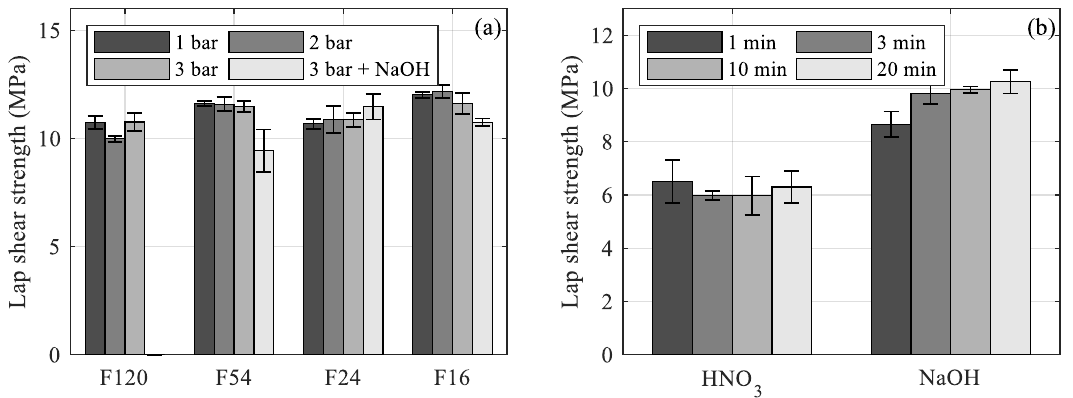
Figure 7. Lap shear test results for ( a ) blasting and combined treatment and ( b ) etching treatment. Table 6. Highest test results and roughness parameters (5 µ m tip) for blasting